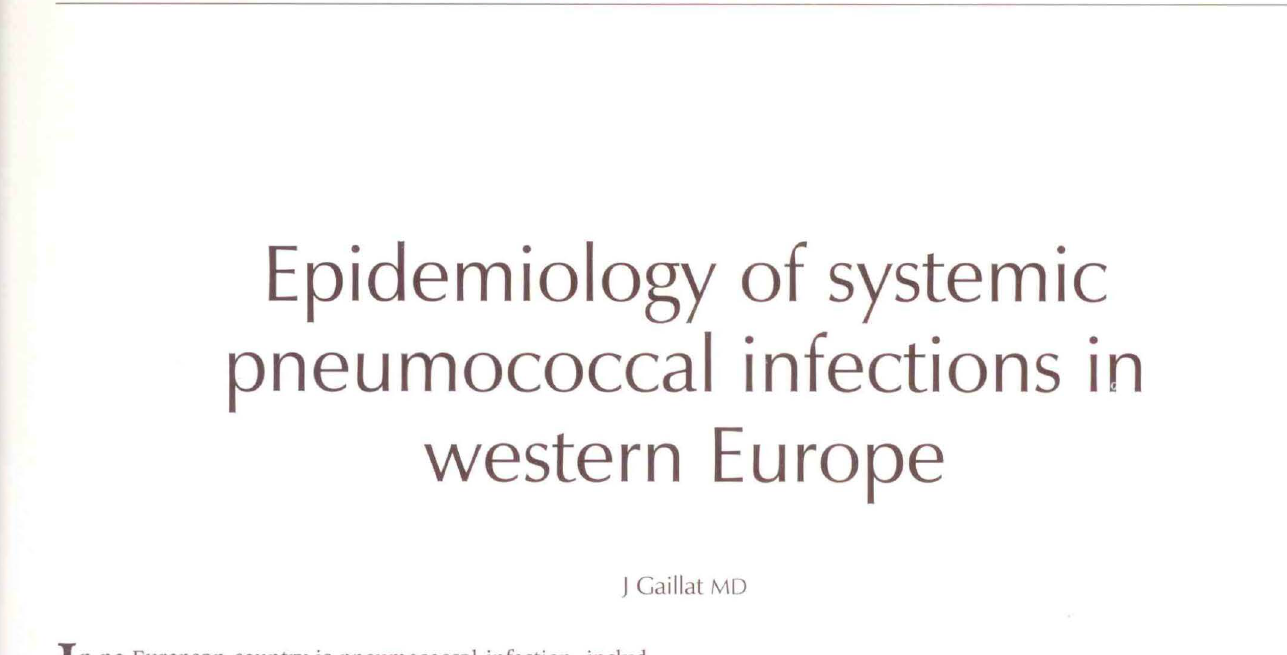
Incidence of invasive pneumococcal disease per 100,000 inhabitants determined by blood culture, cerebrospinal fluid culture and other